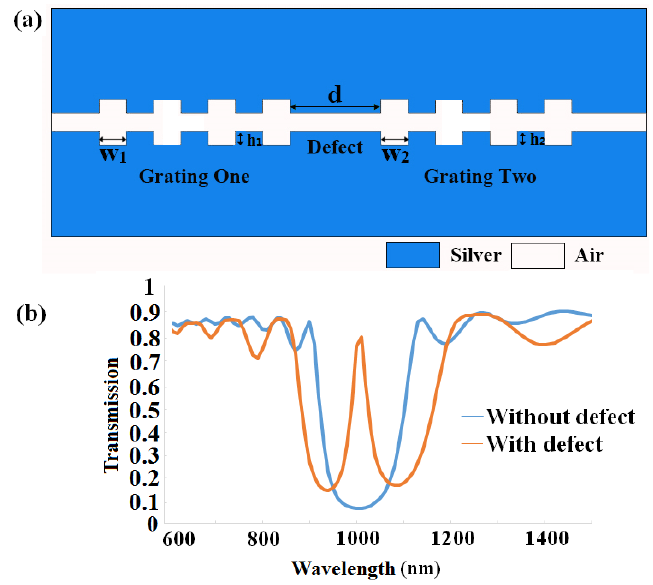
Figure 5. ( a ) The structure of the MIM plasmonic Bragg grating without defect; ( b ) comparison of the Bragg grating and the Bragg grating with a defect d = 400 nm.